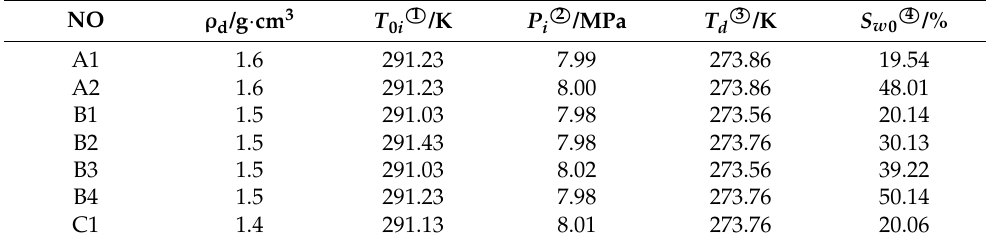
Table 1. Detailed information of tests.